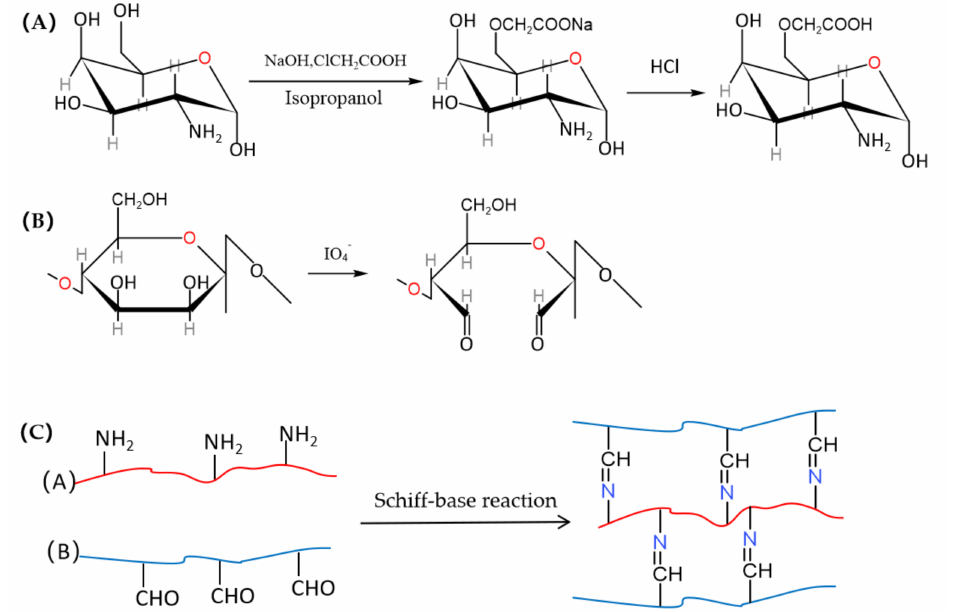
Figure 1. The schematic of O-CCS ( A ), OP ( B ), and OPHs ( C ),